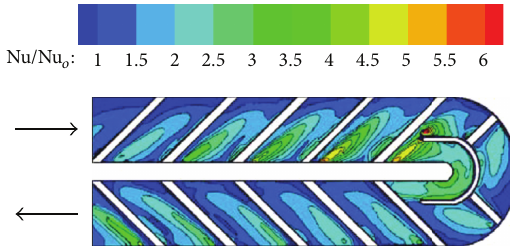
Figure 11: Normalized Nusselt number distribution on the ribbed wall for test section 3, experimental data for Re = 30,000, from Chen et al. [11].